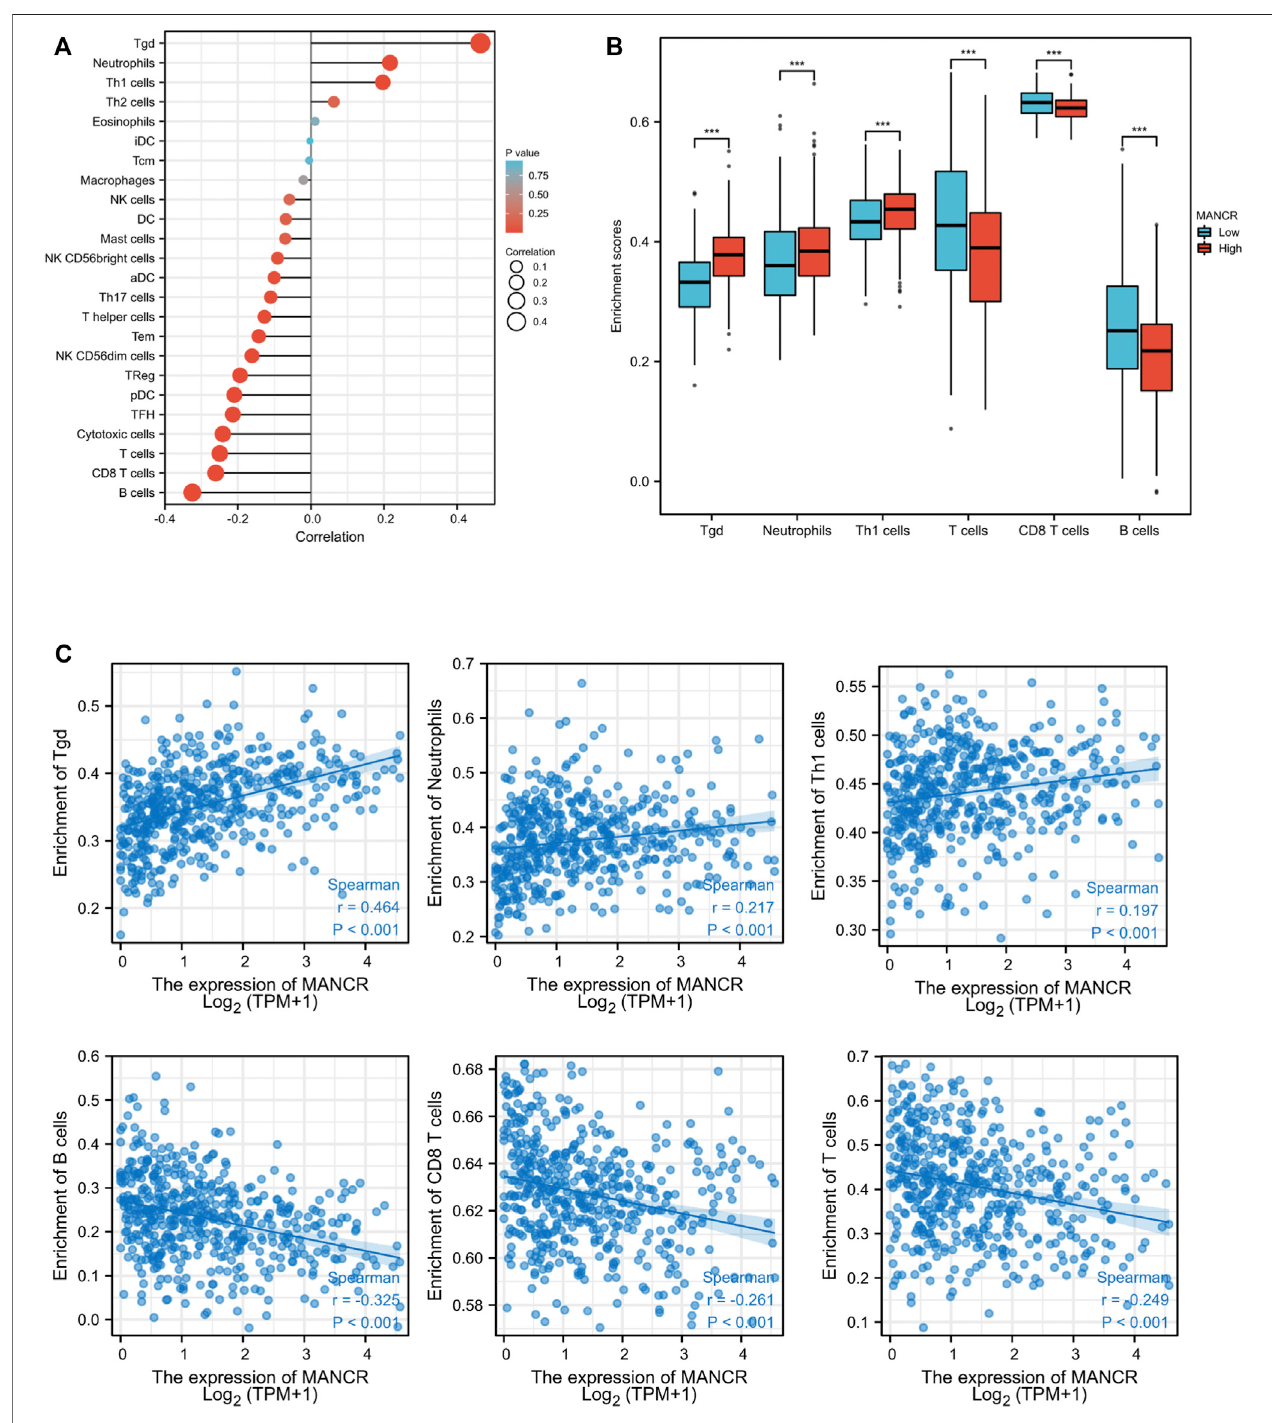
FIGURE 6 | Correlation of MANCR expression with immune cell in fi ltration in HNSCC. (A) Lollipop indicates the correlation between MANCR expression and immune cells subsets. (B) Enrichment scores of tgd cells, neutrophils, Th1 cells, T cells, CD8 T cells, and B cell immune cells with MANCR expression. (C) Spearman analysis revealed the expression distribution of tgd cells, neutrophils, Th1 cells, T cells, CD8 T cells, and B cells in low and high MANCR samples. Data were shown as mean ± SD (* p < 0.05, ** p < 0.01, *** p < 0.001, and **** p < 0.0001).